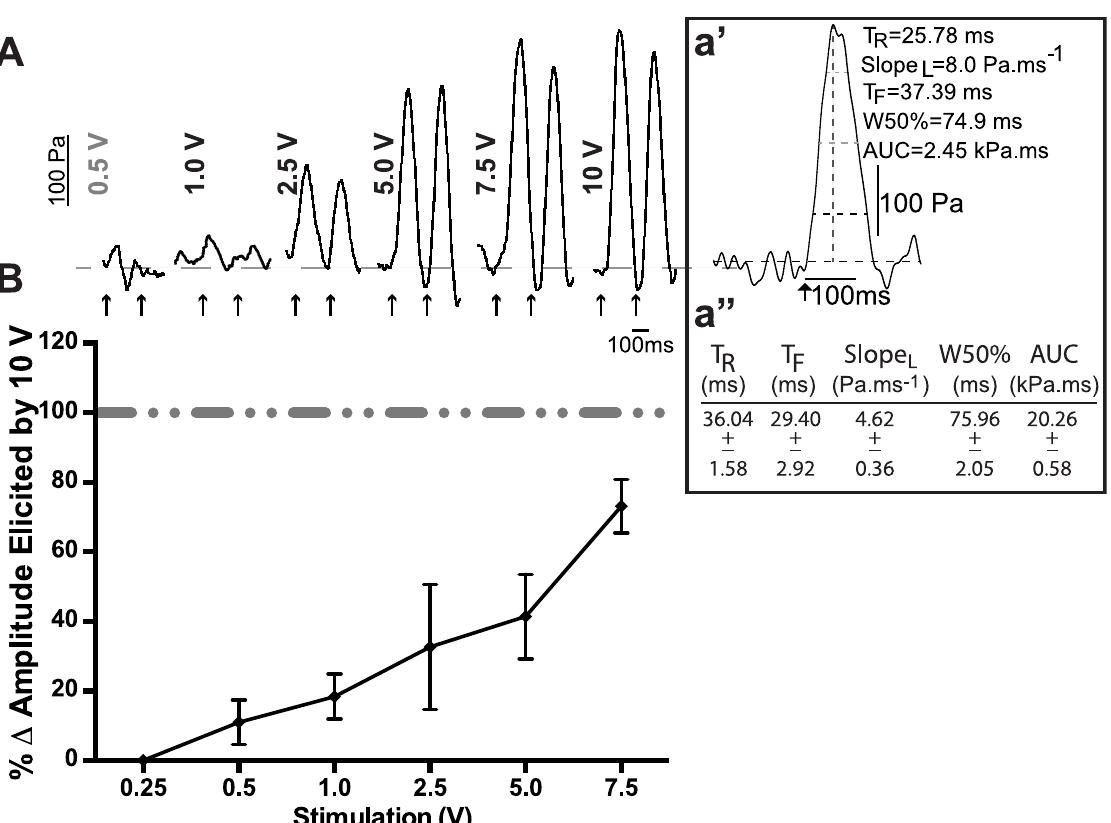
Fig 2. Effect of varying stimulation voltage on magnitude of the contractile response of the aorta. Voltage was varied from 0.25 – 7.5V, whereas frequency and pulse duration were kept constant at 5Hz and 2ms, respectively. (A) Representative tracing of electrically induced contractions of the aorta in response to varying voltage stimuli (two/voltage; bars) and peak parameters (a') of a 10V induced single contraction and (a") the mean ± SEM of 5 contractions per aorta in three animals (arrow; TR = rise time, TF = fall time, SlopeL = leading slope, W50% = half-width, AUC = area under the curve). (B) Graph showing the stimulus-response profile of aortic contractions in relationship to the percent change in amplitude elicited by 10V (n = 4).